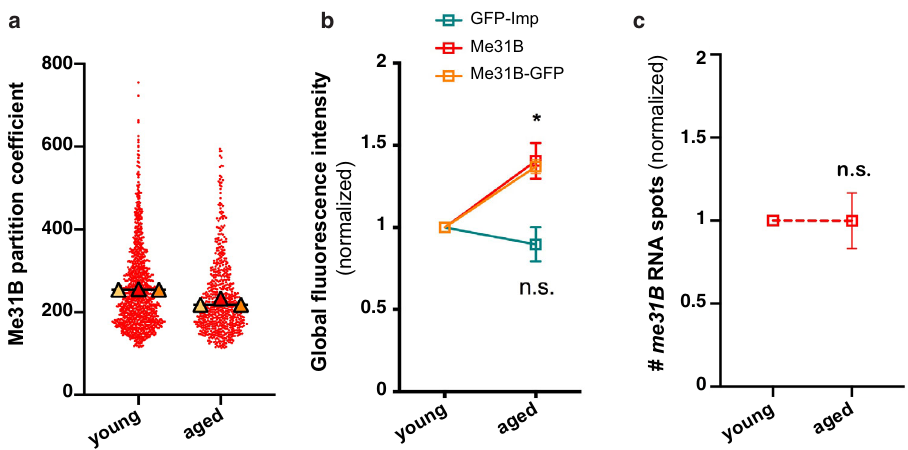
Fig. 4 Me31B levels increase upon aging, a process regulated at the post-transcriptional level. a Partition coef fi cient of Me31B-GFP in 1 – 2 day- (young) and 37 – 38 day- (aged) old brains. Partition coef fi cients were estimated by dividing the maximal intensity of Me31B signal in individual RNP granules to the intensity of the cytoplasmic diffuse pool (see Methods), and calculated for each granule detected in the imaged fi elds. Three replicates were performed and the mean value of each replicate is indicated as a symbol (triangle). The distribution of individual granule partition coef fi cients is shown for one replicate only. b Global Imp and Me31B levels measured from confocal images of 1 – 2 day- (young) and 37 – 40 day- (aged) old MB γ neurons. Imp levels were measured using endogenously expressed GFP-Imp fusions (green). Me31B levels were measured using both endogenously-expressed Me31B-GFP fusions (orange) and α -Me31B antibodies (red). * P < 0.05 (Kruskall – Wallis test; n = 3; P = 0.02). c Normalized numbers of gfp smFISH spots counted in 1 – 2 day- (young) and 37 – 38 day- (aged) old Me31B-GFP-expressing brains. n.s. stands for not signi fi cant (unpaired, two-sided Mann – Whitney test on replicate means). In b , c , data points represent the mean values obtained from three independent replicates. Error bars correspond to s.e.m. Values were normalized to the young condition. At least 10 fi elds were imaged per replicate and per condition. * P < 0.05. Source data are provided as a Source Data fi